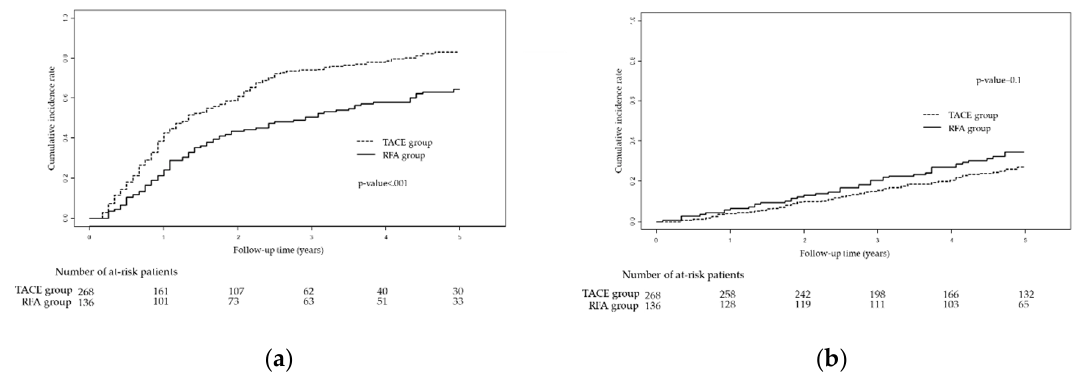
Figure 1. Kaplan-Meier curves showing ( a ) recurrence-free survival and ( b ) overall survival for TACE vs. RFA groups based on the entire cohort. Abbreviations: TACE, trans-arterial chemoembolization; RFA, radiofrequency ablation